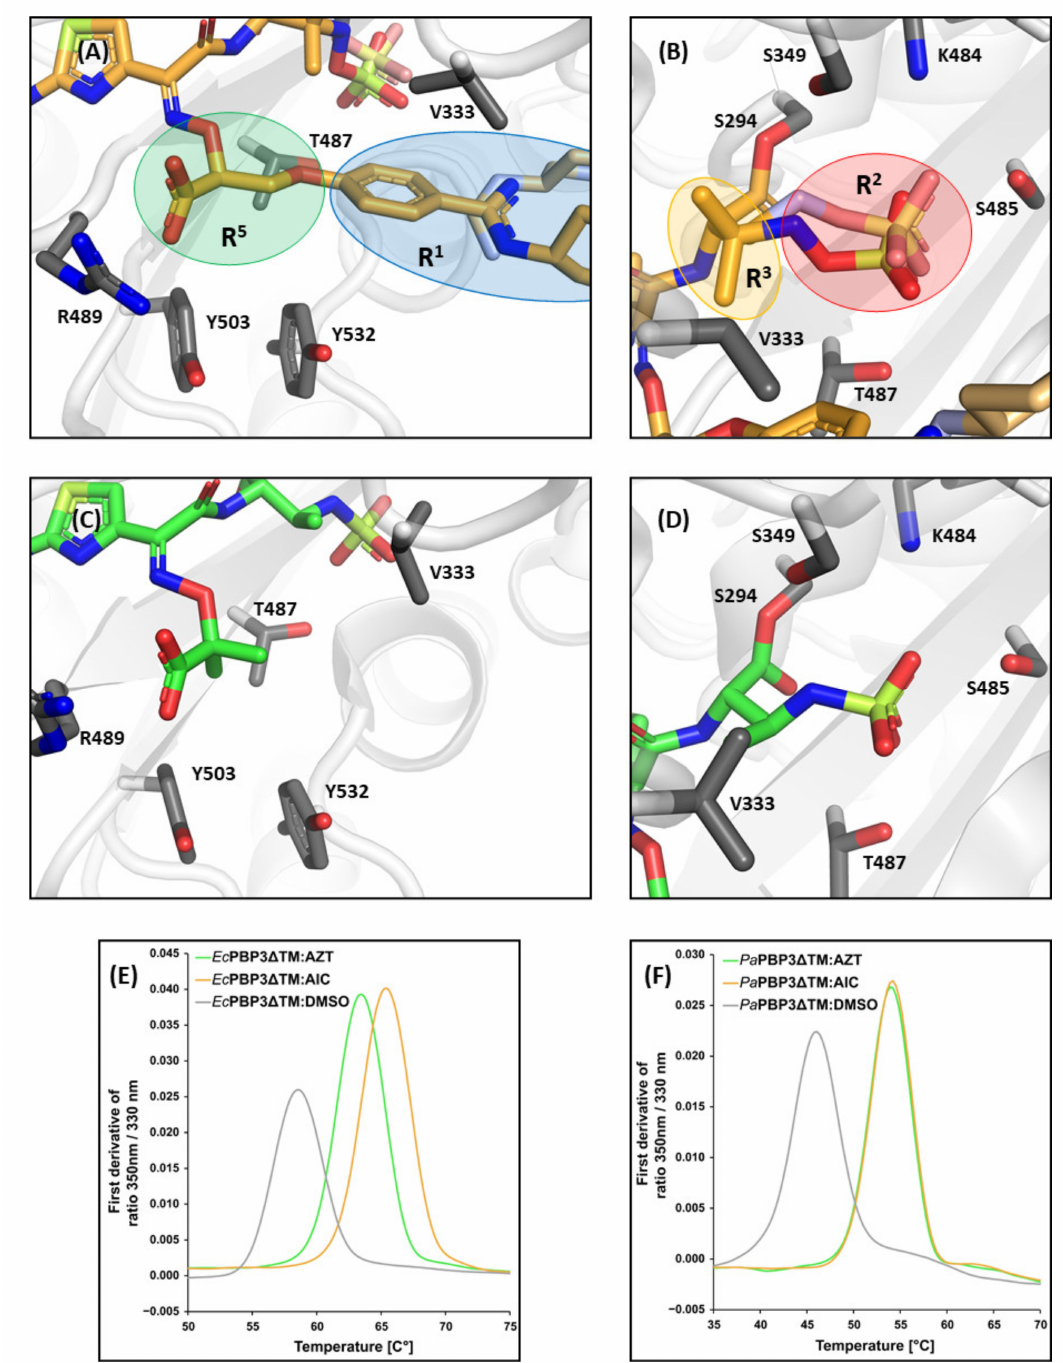
Figure 7. Comparison of aztreonam and AIC499 binding to Pa PBP3 and Ec PBP3. Panel ( A ) shows a close-up view of the linker (R 5 ; green) and head group (R 1 ; blue) of AIC499 in complex with Pa PBP3 ∆ TM, while ( B ) focuses on the sulfate (R 2 ; red) and dimethyl group (R 3 ; orange). The analogous views of aztreonam in complex with Pa PBP3 ∆ TM (PDB entry 3PBS [11]) are represented in ( C , D ), respectively. Refer to Table A2 for a complete list of distances between protein side chains and the aztreonam molecule. ( E ) DSF data obtained with Ec PBP3 ∆ TM; the first derivative of the 350 nm/330 nm fluorescence ratio is plotted against the temperature. The control experiment with DMSO added to the protein (gray) yields a T m of 58.6 ◦ C, which increases to 63.4 and 65.4 ◦ C after addition of 500 µ M aztreonam (AZT, green) and AIC499 (AIC, gold), respectively. ( F ) Analogous experiments with Pa PBP3 ∆ TM measured in complex with aztreonam (green) and AIC499 (gold) gave nearly identical T m values of 54.0 and 54.1 ◦ C, respectively. The T m for the control experiment (gray) was determined to be 46.0 ◦ C. Raw data of the thermal shift experiments are shown in Figure